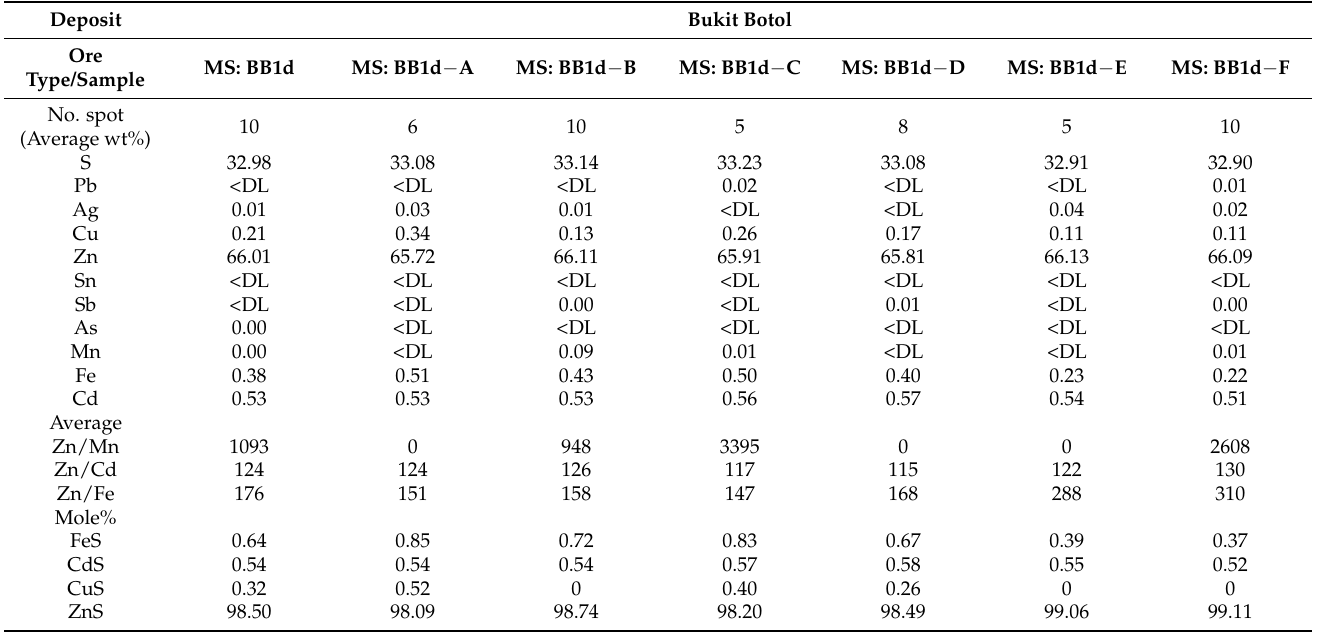
Table 1. Average chemical compositions of the representative sphalerite in a massive sulphide lens from the Bukit Botol deposit, Central Peninsular Malaysia. Deposit Bukit